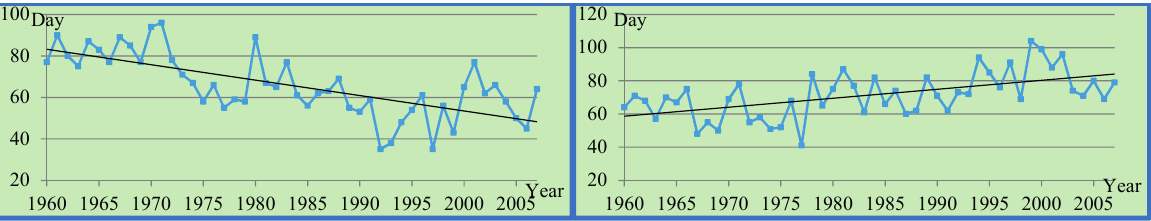
Figure 7. The most significant negative trend with a slope of − 0.7432 ( left ) and the most significant positive trend with a slope of 0.5404 ( right ) of the R10mm